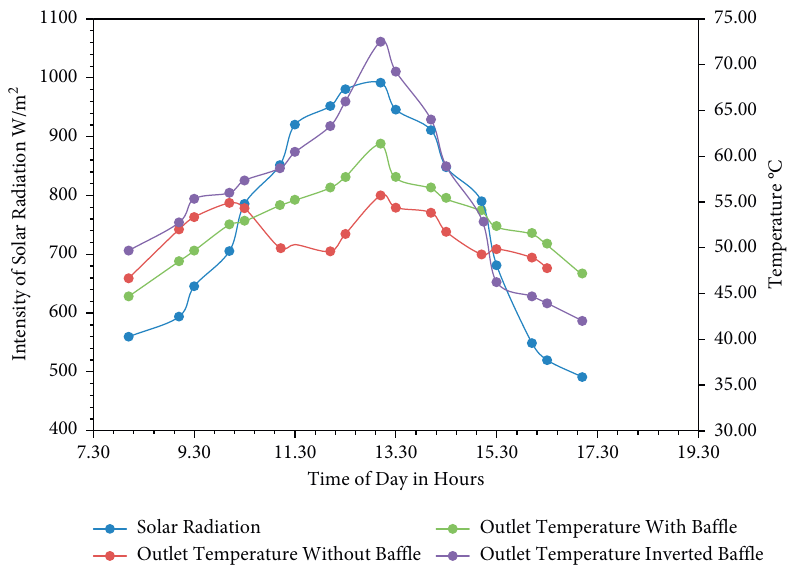
Figure 3: Outlet temperatures with respect to solar radiation of